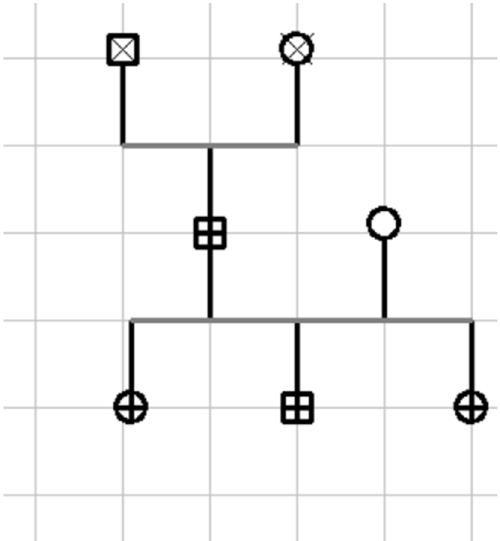
Figure 6. Familiar pedigree: non-carrier female: ; woman affected by the mutation: ; man affected by the mutation: ; man (deceased) clinically unaffected by the mutation: ; woman (deceased) clinically unaffected by the mutation: . RyR2 is an essential Ca 2+ release channel of the sarcoplasmic reticulum and plays a